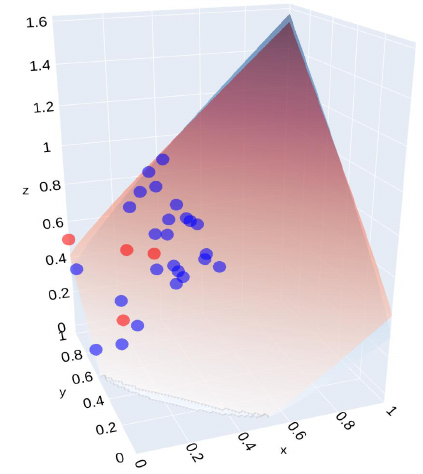
Figure 7. Parameter estimation with the use of an evolutionary algorithm for the average case. The blue points represent the samples with r = 0.75, whereas the red points are the ones that were created with r = 1 or r = 1.25. The blue surface is the one created by the application of function (11) with the original r = 0.75. The red surface is the one created by the application of the same function with the best found r =